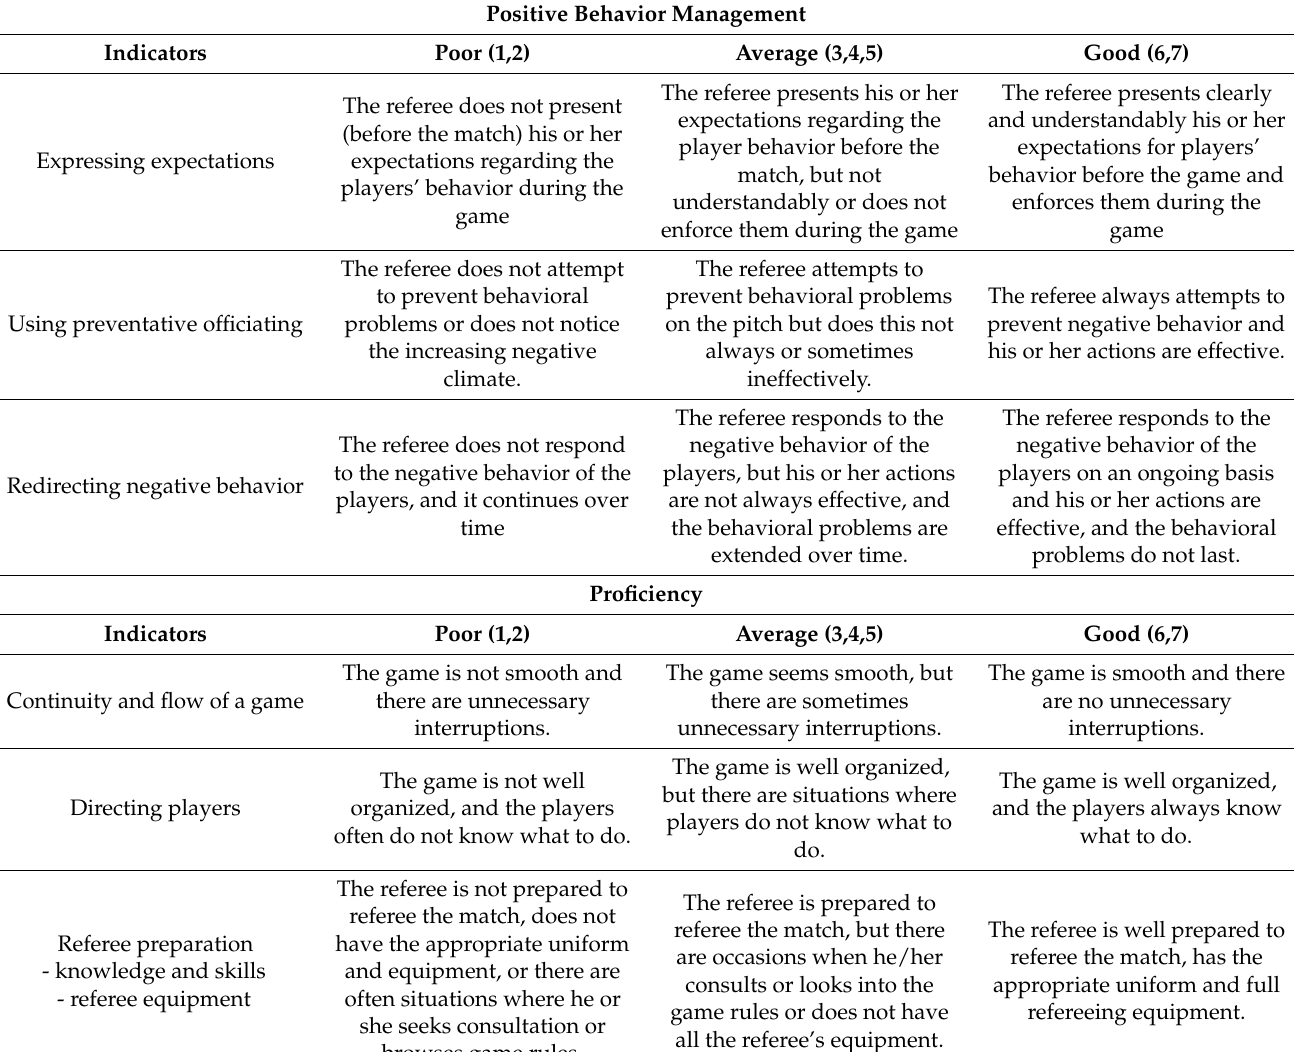
Table 1. Criteria for the assessment of the quality of referee–player interaction in the dimensions of positive behavior management and proficiency